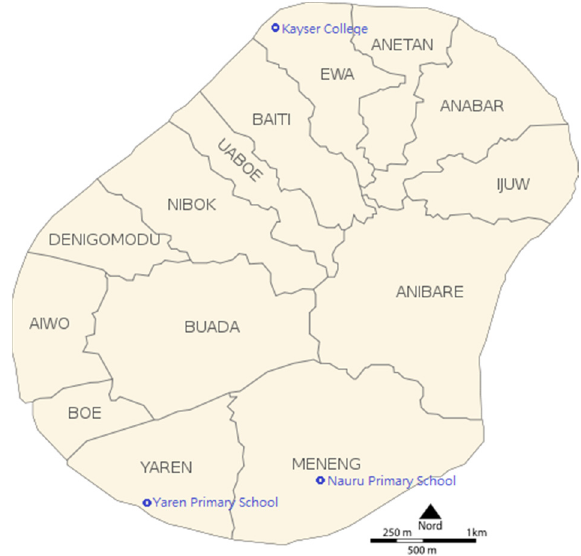
Figure 1. Map of Nauru with the location of the three primary schools.